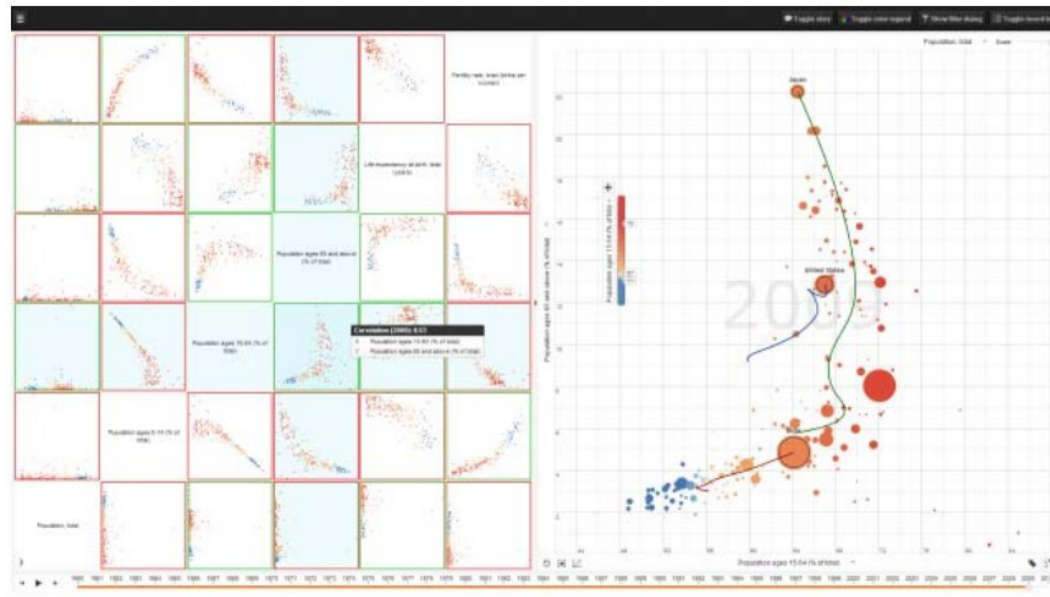
Figure 9. Lundblad and Jern show Vislet aimed at a comparative visualization using linked Scatter Matrix and Scatter Plot to analyze national correlation between 6 indicators between 1960 and 2010 from the World Databank [23]. Image courtesy of Lundblad and Jern [23].